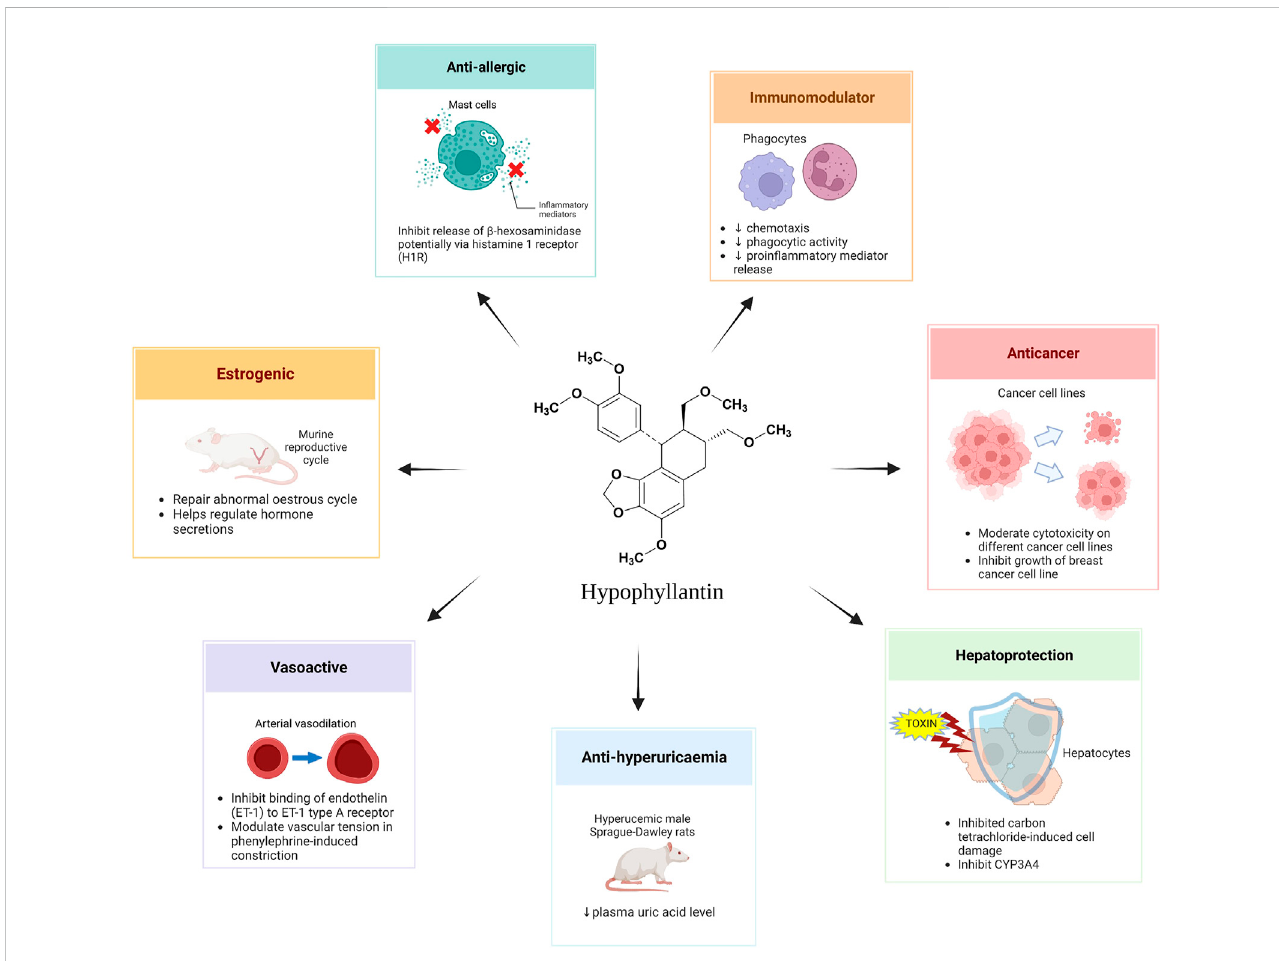
FIGURE 3 Pharmacological activities from hypophyllanthin from in vitro and in vivo